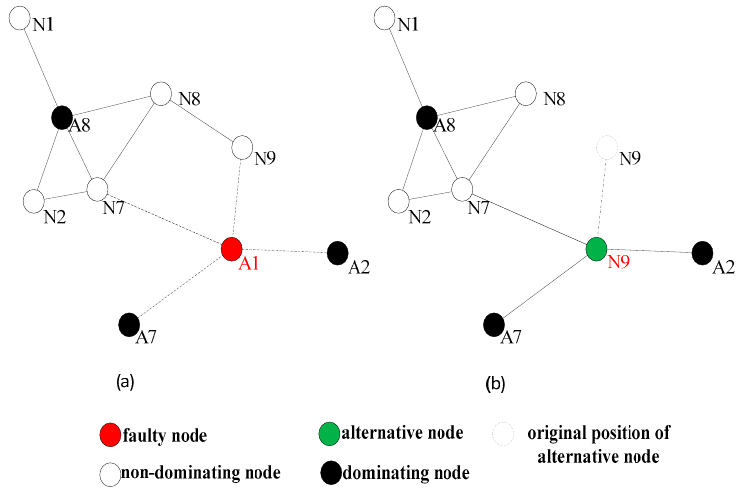
Figure 4. Connectivity restoration process with single node relocation.